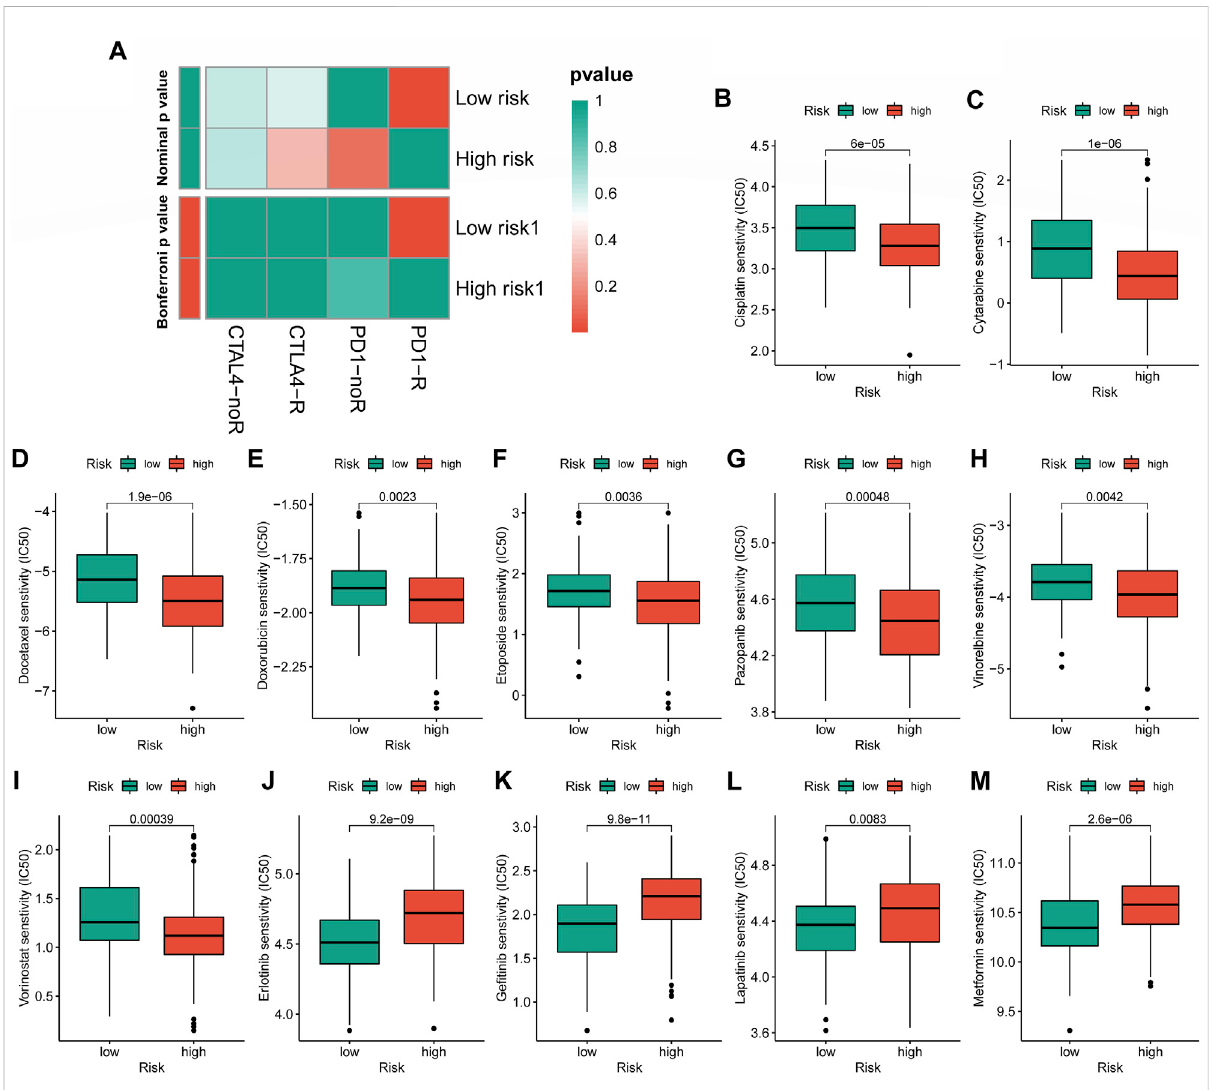
FIGURE 10 Evaluation of immunotherapy response and chemotherapy sensitivity in STS with a different risk score. (A) The therapeutic responses to immunecheckpointinhibitorsinSTSpatients. (B – M) ThedifferencesinestimatedIC50valuesof12representativedrugsbetweenthehigh-andlow- CRLncSig